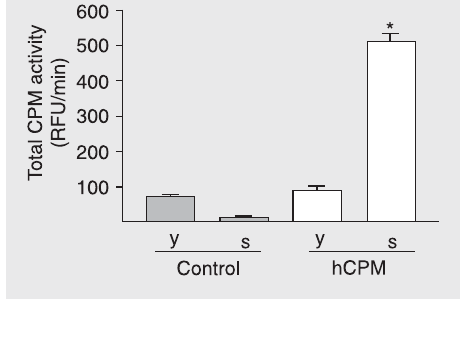
Figure 2. Carboxypeptidase M activity in the culture superna- tant of the GS115-CPM strain. Cells were induced in buffered minimal methanol and the activ- ity was evaluated with the sub- strate dansil-Ala-Arg at different times. RFU = relative fluores- cence units. *P < 0.05 and **P < 0.01 compared to the 24-h cul- ture ( t -test).